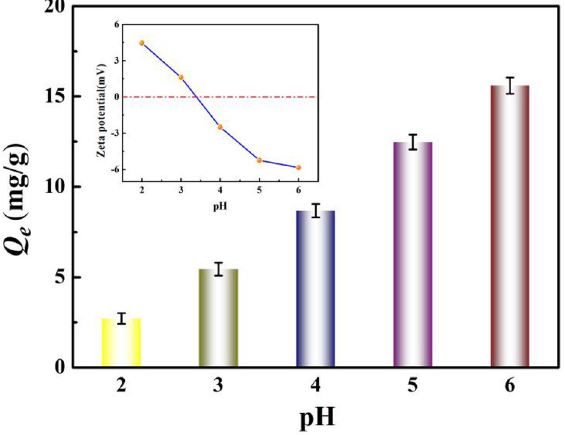
Figure 4. The effect of solution pH on the adsorption of Ni(II) by